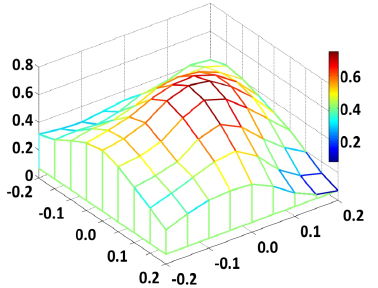
Figure 4. The correlation (y-axis) between the silhouette and backscattering intensity was examined by shifting the reference data in XY. Strip-level errors XY were eliminated, using this approach.